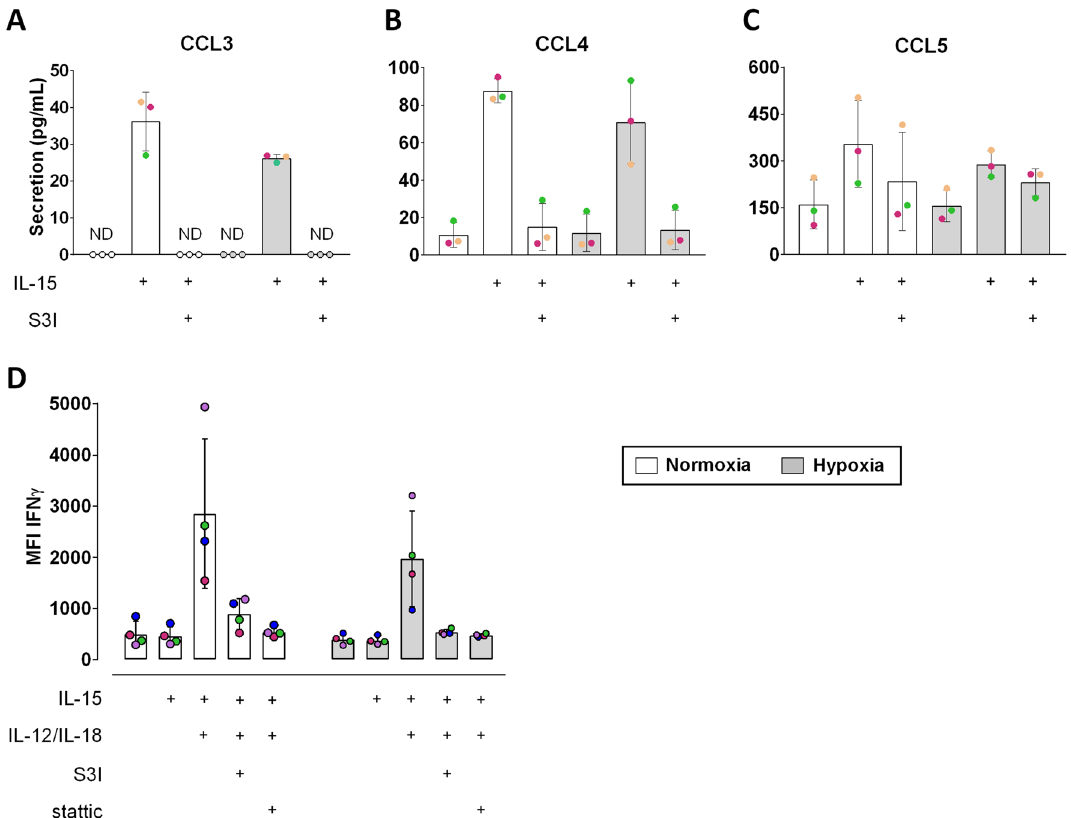
Figure 4. STAT3 inhibition interferes with CCL3/CCL4 secretion and IFNγ production in NK cells. NK cells were incubated under normoxia or hypoxia for 16 h and treated with IL-15 alone ( A − C ) or in combination with IL-12/IL-18 ( D ) for additional 6 h in the presence or absence of STAT3 inhibitors (S3I-201, stattic) as indicated. ( A − C ) Bead array analysis of secreted chemokines. Bars represent mean chemokine concentrations ± SD (n = 3). The level of statistical significance was not reached when applying the Wilcoxon signed-rank test. ND: not detectable. ( D ) Pooled flow cytometric data for the proportions of IFNγ median fluorescence intensities (MFI), shown as mean values ± SD (n = 4). The level of statistical significance was not reached when applying the Wilcoxon signed-rank